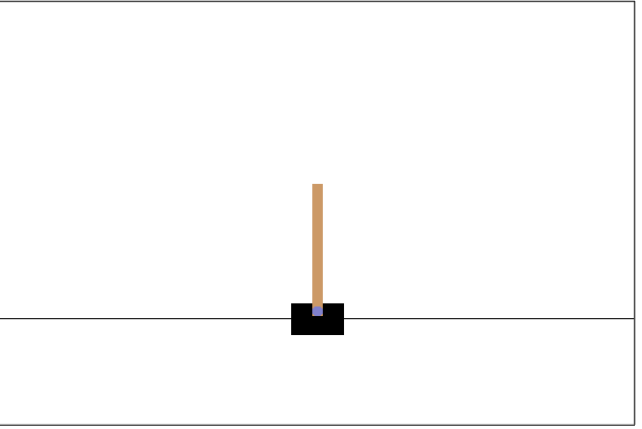
Figure A1. The illustration of the Cartpole environment from openAI